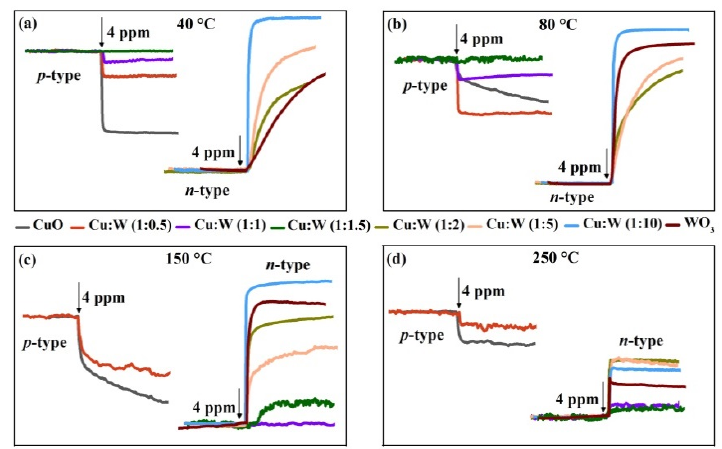
Figure 4. Dynamic curves of the CuO/WO 3 composites with different Cu/W molar ratios upon 4 ppm H 2 S gas at ( a ) 40 °C, ( b ) 80 °C, ( c ) 150 °C, and ( d ) 250 °C.